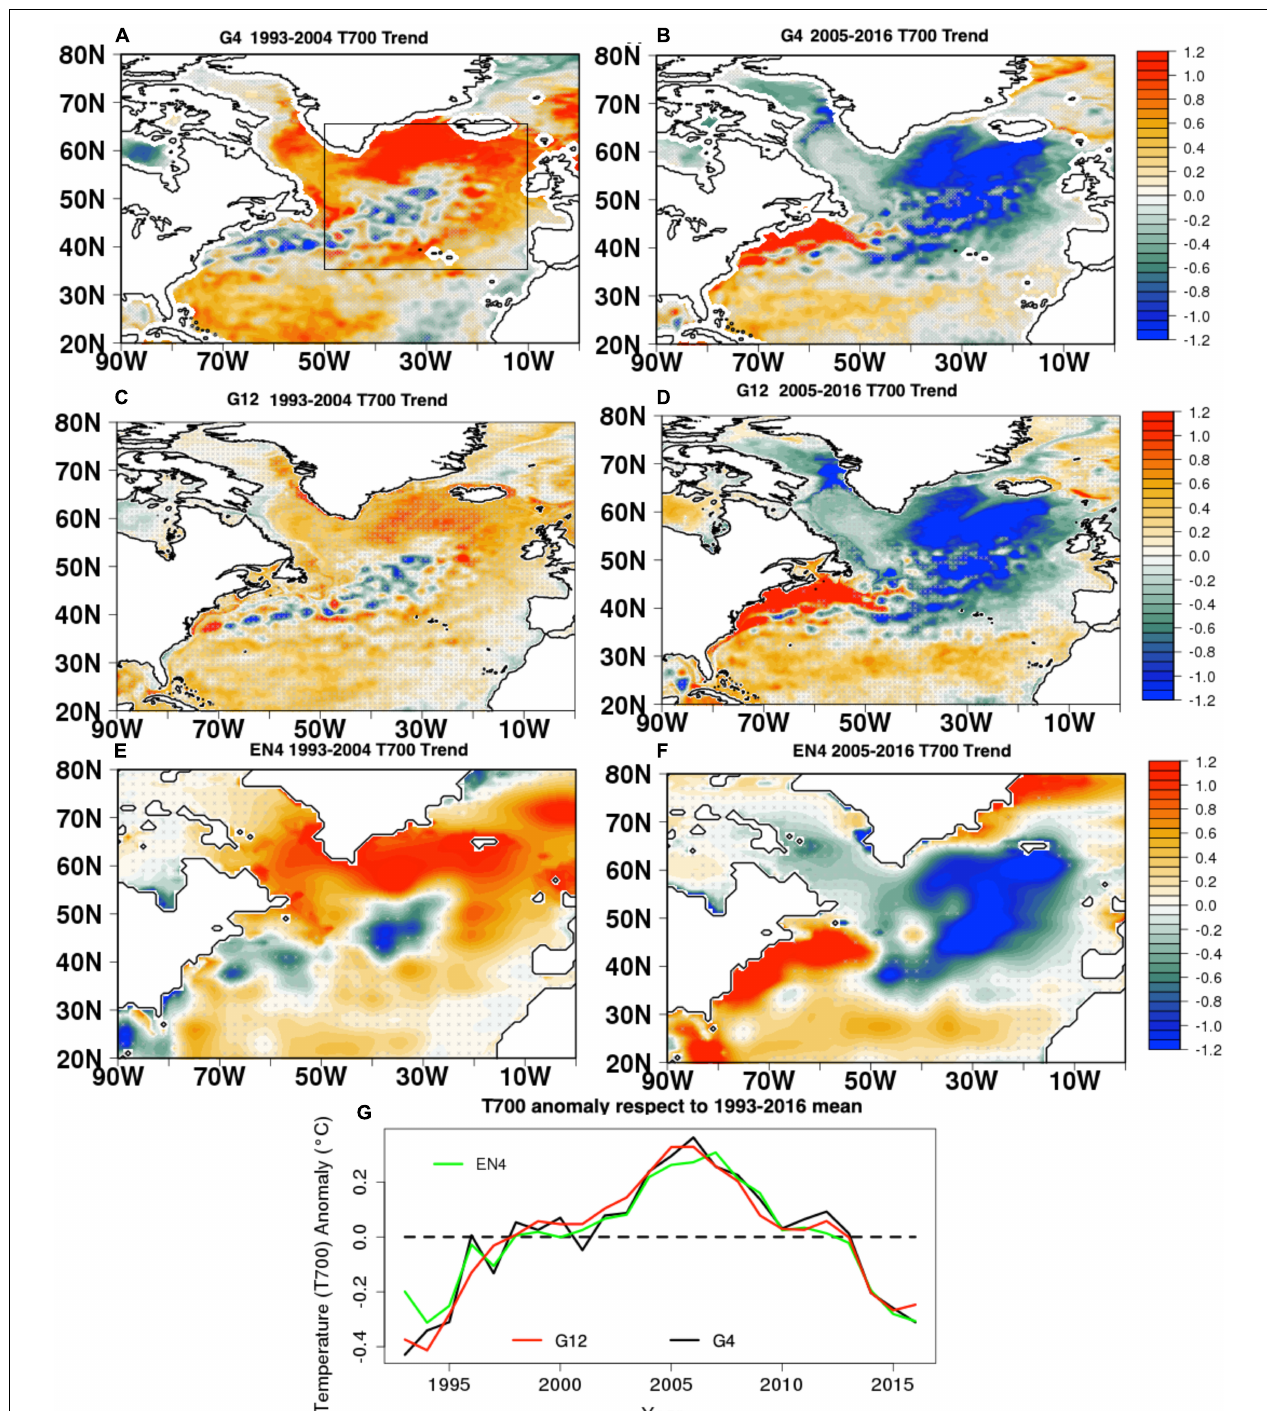
FIGURE 2 | Top 700 temperature (T700) linear trend (unit: ◦ C per decade) (A) from 1993–2004 in G4, (B) from 2005 to 2016 in G4, (C) from 1993–2004 in G12, (D) from 2005 to 2016 in G12, (E) from 1995–2016 in EN4, (F) from 2005–2016 in EN4 and (G) T700 anomaly respect to 1993–2016 mean averaged in the boxed regions (35 N–65 N. 10 W–50 W) shown in panel (A) for G4 (black), G12 (red) and EN4 (green). In panels (A–F) regions that do not pass t -test 95% confidence interval are marked with light gray cross.